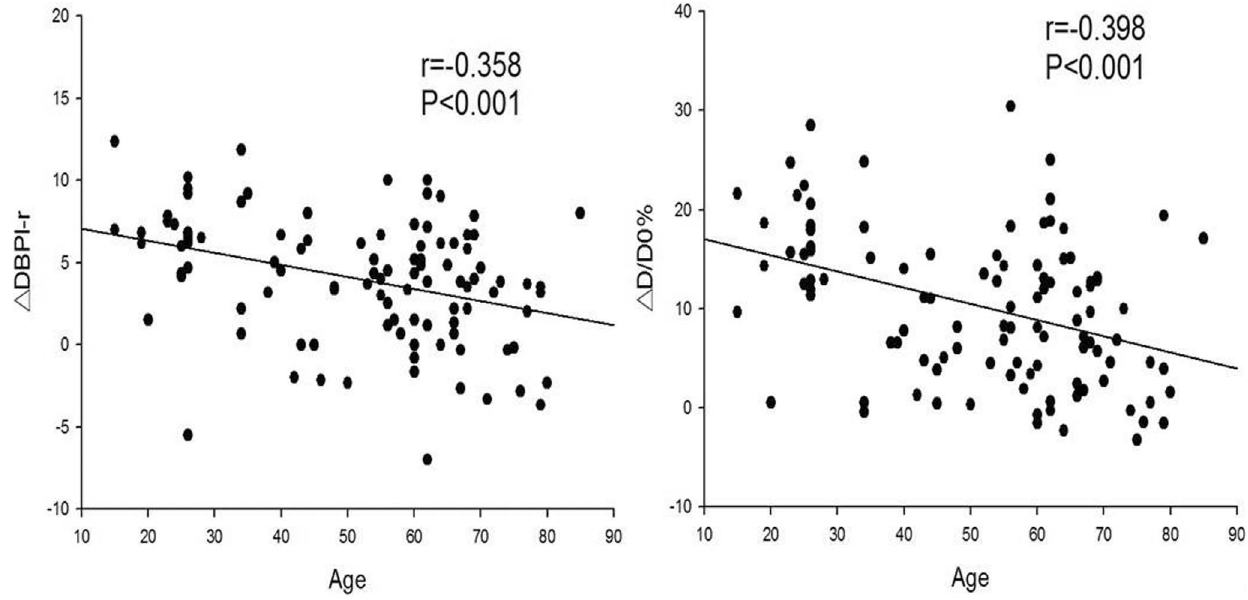
Figure 2. The correlation of age with D DBPl-r and D D/D0. D D/D0: percentage increase in right brachial artery diameter. D DBPl-r: DBPl-r change following ischemia. (DBPl-r: The DBP difference between left and right arms).